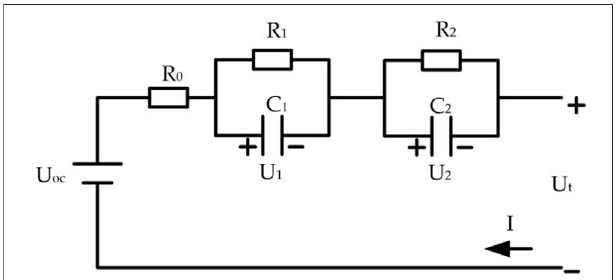
FIGURE 1 | Second-order RC battery